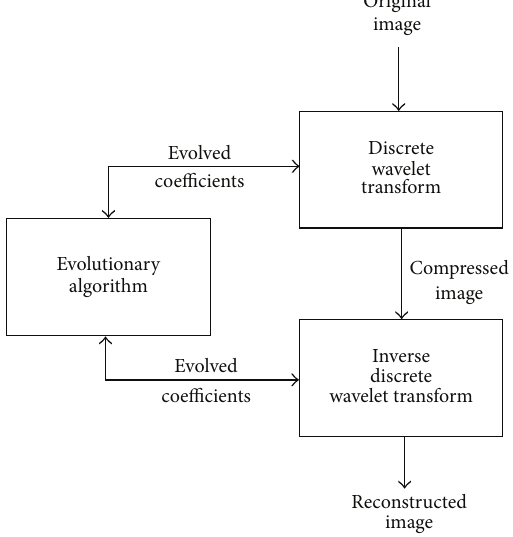
Figure 3: Evolutionary wavelet